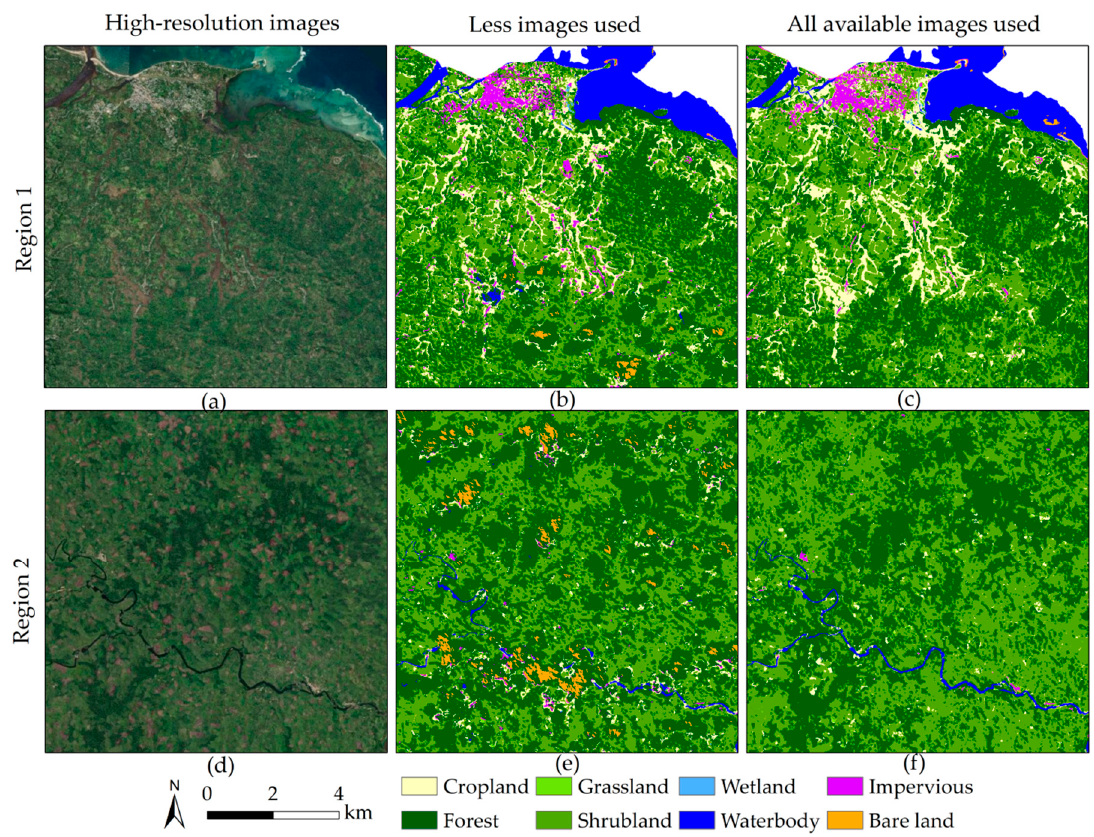
Figure 8. Examples of comparisons of the classification performances using Sentinel-2 images with cloud cover below 10% (i.e., n = 4900 images, b , e ) and using all available Sentinel-2 images (i.e., n = 11,083 images, c , f ) over the entire island. ( a , d ) were derived from high-resolution Google earth imagery.